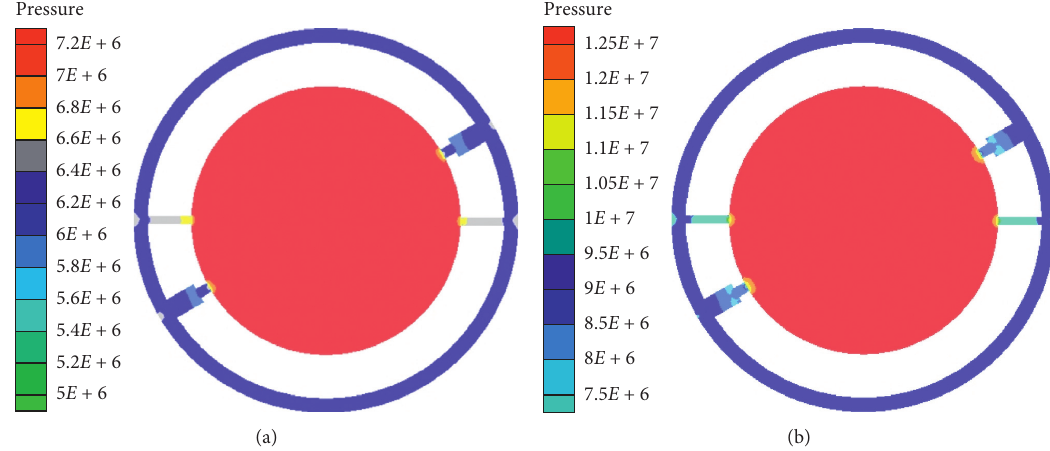
Figure 8: Pressure distribution contours at a cross-section of the damping valve in compression stroke at (a) t � 0.05s and (b) t � 0.1s. Volume fraction of nitrogen phase